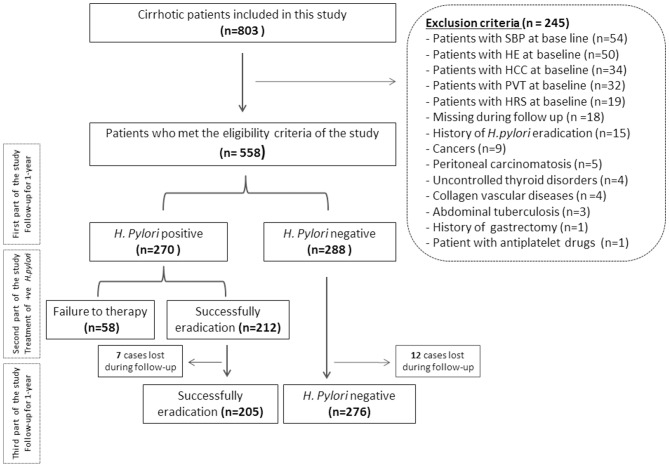
Flowchart of the patients included in this study. SBP, spontaneous bacterial peritonitis; HE, hepatic encephalopathy; HCC, hepatocellular carcinoma; PVT, portal vein thrombosis; HRS, hepatorenal syndrome; H. pylori, Helicobacter pylori.